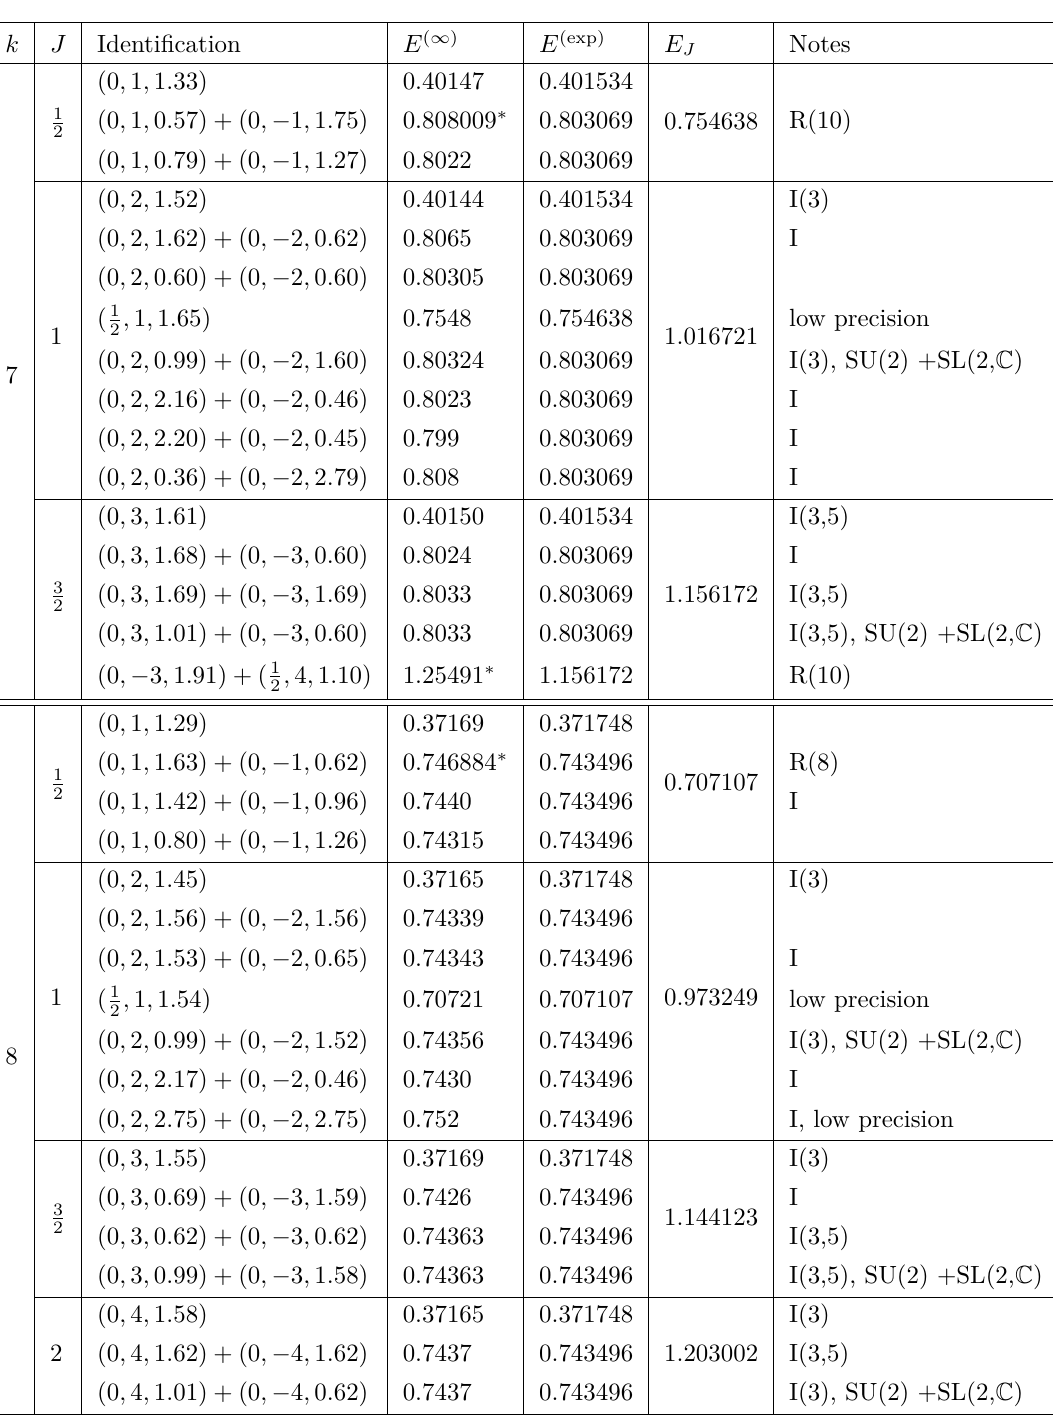
Table 15 . List of SL(2, C ) Cardy solutions in models with k ≤ 8 , part